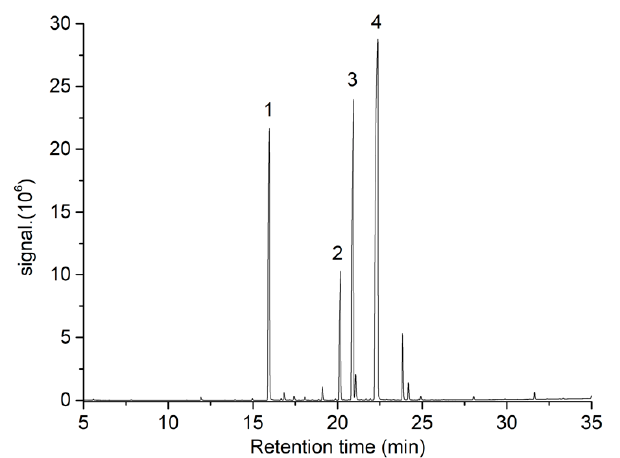
Figure 2. GC-MS chromatogram obtained from TSO by MAE. Peaks labeled as 1, 2, 3, and 4 correspond to methyl palmitate, methyl stearate, methyl oleate, and methyl linoleate, respectively.